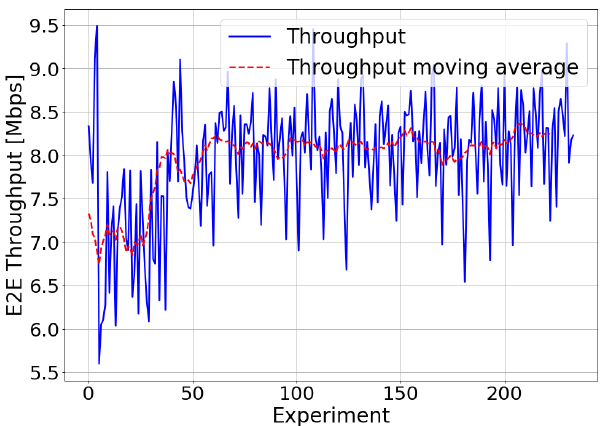
Figure 11. Real environment—E2E throughput